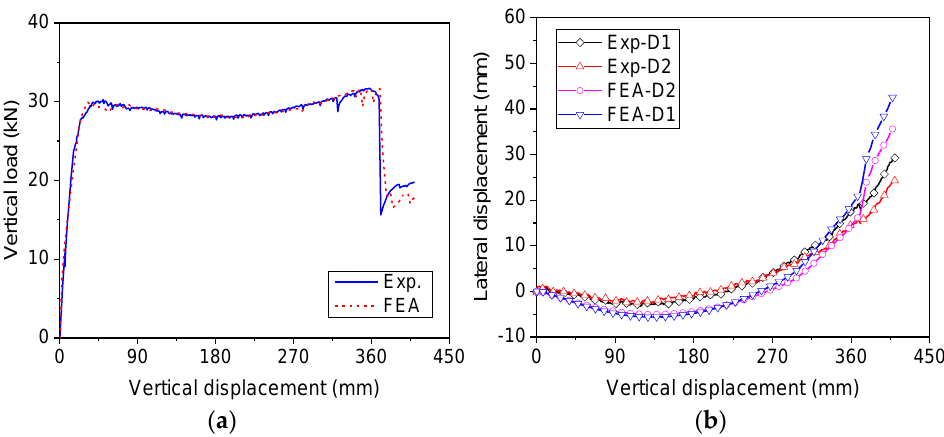
Figure 7. Comparisons between experimental and numerical results of single-storey frame: ( a ) load – displacement curve; ( b ) lateral displacement of side columns.